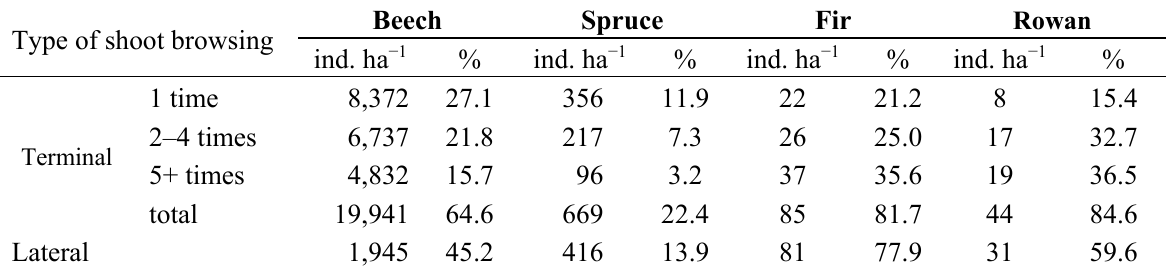
Table 5. Browsing to natural regeneration on unfenced PRP 2 broken down by tree